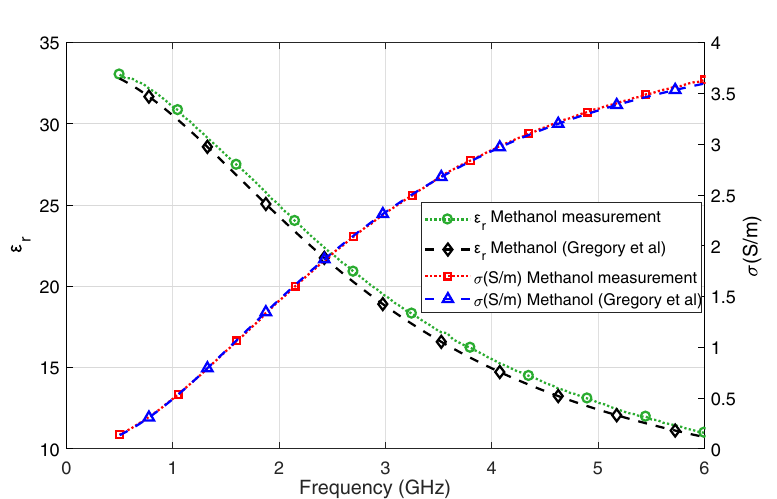
Figure 4. Comparison of measured methanol dielectric properties with the literature data 21